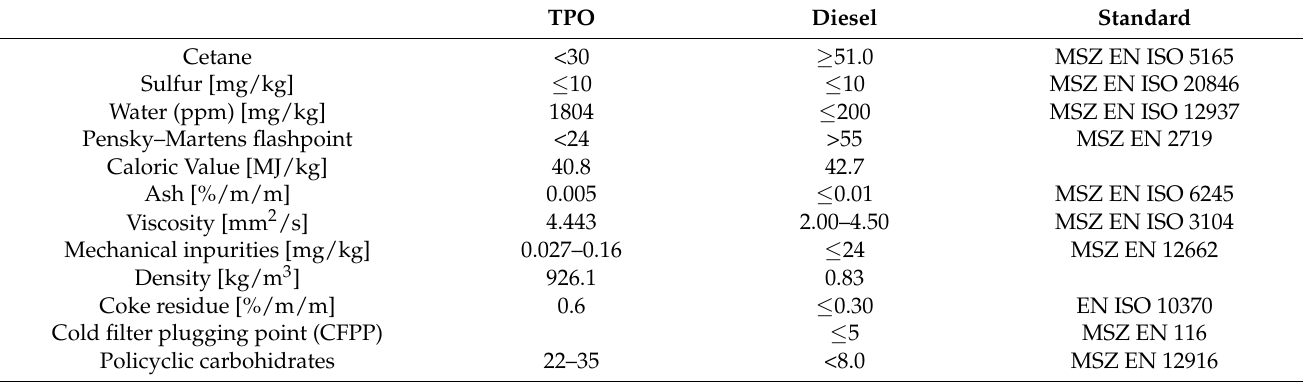
Figure 1. Shematic diagram of experimental setup. Table 1. Main parameters of TPO and diesel